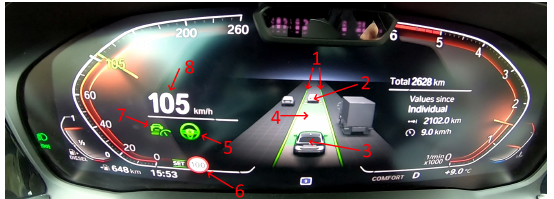
Figure 6. BMW HMI design and corresponding icon number.